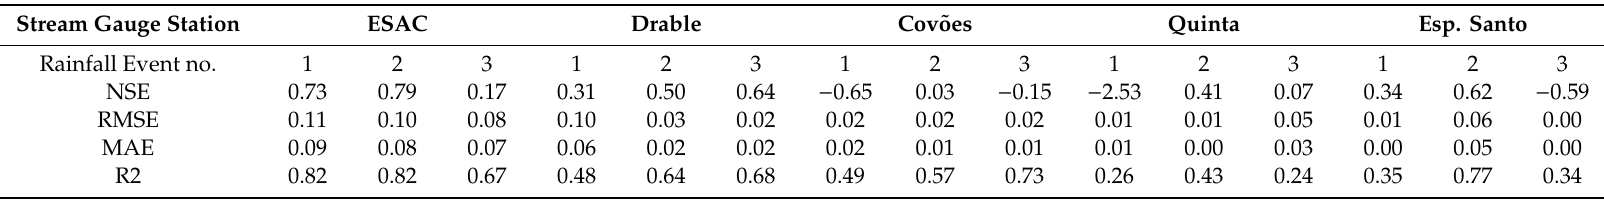
Table 3. Predictive performance of the hydrologic HEC-HMS model in simulating hourly runo ff at the outlet of Ribeira dos Cov õ es catchment (ESAC) and in three upstream sub-catchments (Drable, Cov õ es, Quinta, Esp í rito Santo) during three single validation events, based on four performance criteria (Nash–Sutcli ff e e ffi